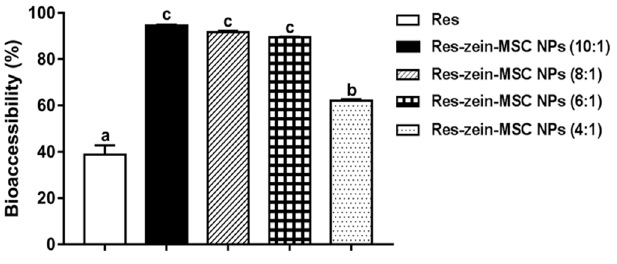
Figure 4. The bioaccessibility of Res and Res-zein-MSC NPs. Here, different letters represent significant differences ( p < 0.05).